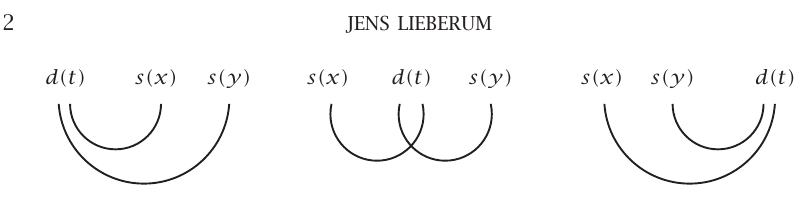
Figure 3.3 . Configurations of (s(x),s(y),d(t)) and